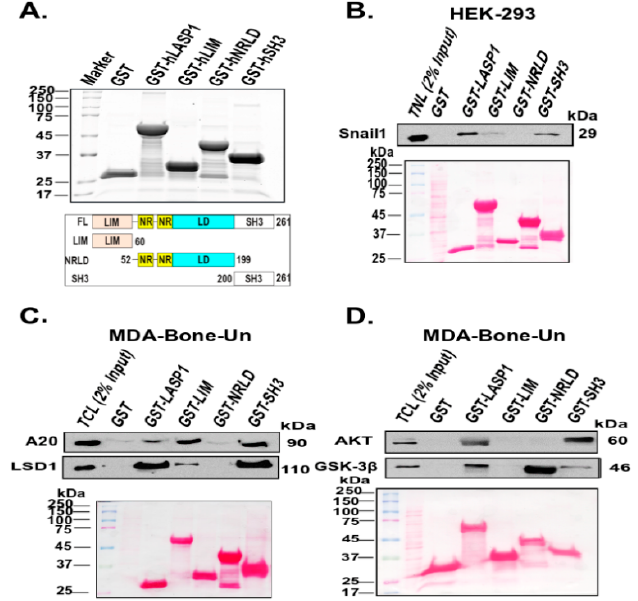
Figure 3. Domains of LASP1 differentially associate with Snail1 and its stabilizing proteins. ( A ) Top panel – Affinity purified full length LASP1 and its domains fused to GST were separated by 10% SDS-PAGE. Proteins were visualized by staining the gel with Imperial Blue Protein Stain; Bottom panel – A schematic depiction of the constructs of recombinant full length of LASP1 and its various domains that were bacterially expressed ( B ) Association of LASP1 and its domains with Snail1 upon stimulation of stably expressed CXCR4 by CXCL12. Notably, 1.5 nmol of each of the GST and LASP1 and its domains fused to GST were incubated with 200 µg of nuclear lysate derived from 293-CXCR4 cells that were transiently expressing Flag-Snail1-WT and stimulated with 20 nM CXCL12. The association of Flag-Snail1 with full length LASP1 and its domains were analyzed by 10% SDS-PAGE, followed by immunoblotting; n = 3 ( C ) and ( D ) Association of LASP1 and its domains with proteins that contribute to the stabilization of the Snail1. Nuclear lysates were prepared from MDA-Bone-Un cells that were serum-starved and stimulated with 20 nM CXCL12. 1.5 nmol of each of the GST and LASP1 and its domains fused to GST were incubated with 250 µg of nuclear lysate derived from CXCL12-stimulated MDA-Bone-Un cells. The association of endogenous A20, LSD1, AKT and GSK- 3 β with full length LASP1 and its domains were analyzed by 10% SDS-PAGE followed by immunoblotting; n = 3.